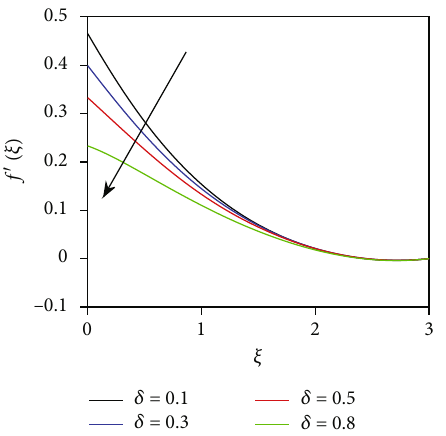
Figure 5: Radial velocity pro fi les for velocity slip parameter δ .